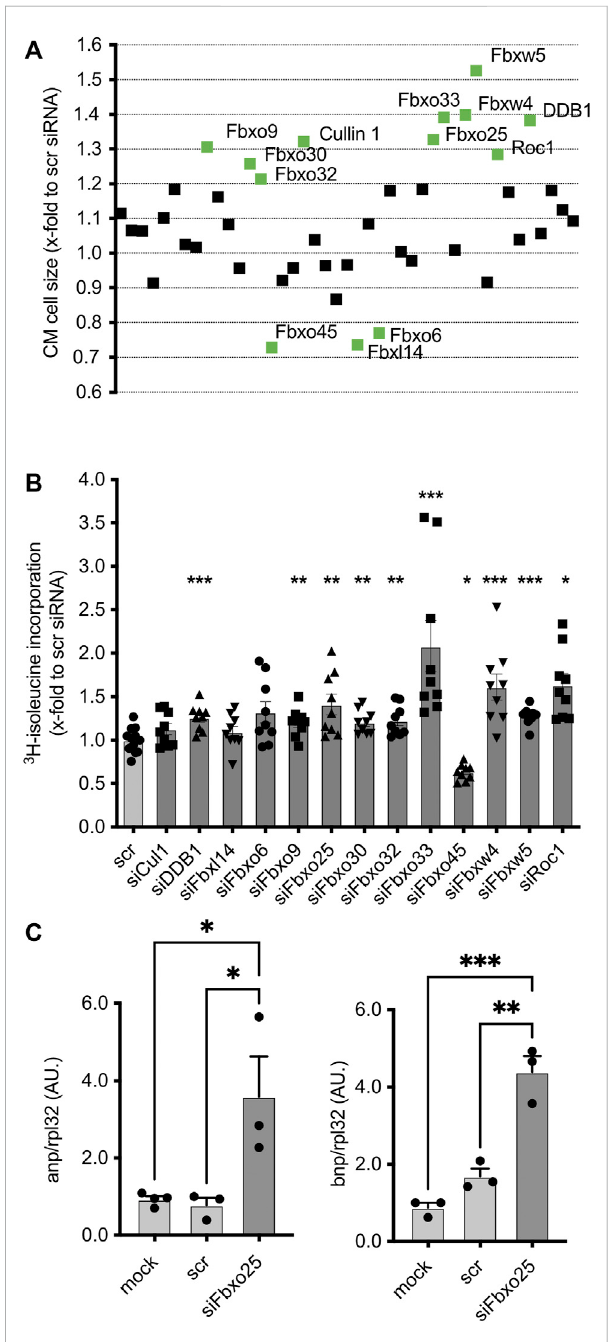
FIGURE 2 Effect of transfected siRNAs on CM at basal conditions. (A) Effect of transfected siRNAs on CM size upon basal condition without PE. Data are normalized to scramble control (scr). Screening targets are depicted on the x -axis. Three independent experiments with > 50,000 cells per group. Statistical signi fi cance between the screening targets was analyzed by 1-way ANOVA and Bonferroni post hoc test . The labelled screening hits are highly signi fi cant (labelled in green). (B) Validation of cell size changing siRNA-mediated knockdown effect on cardiomyocytes by 3H- isoleucine incorporation without PE. Data were normalized to scramble siRNA control. Dots depict cumulative data from three independent cell preparations. Independent experiments: N = 3, n = 10 – 11. Histogram shows data under basal conditions without phenylephrine (PE). Data are mean ± SEM. One- way ANOVA with Bonferroni post hoc test, * p < 0.05, ** p < 0.01, *** p < 0.001. (C) mRNA concentrations of hypertrophy markers